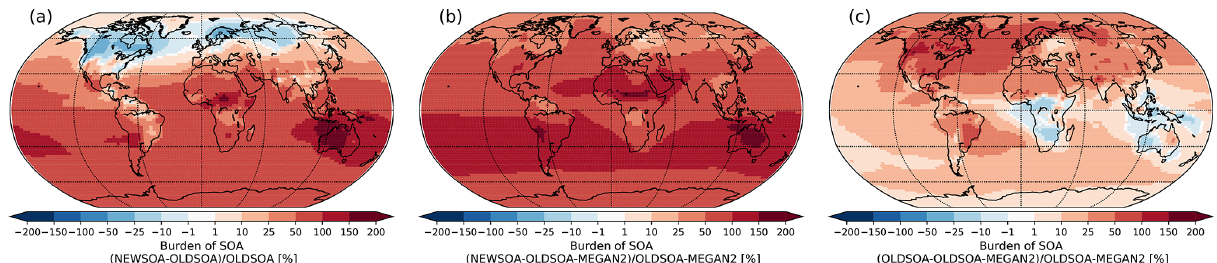
Figure 5. Fractional change in atmospheric burden of secondary organic aerosol between simulations NEWSOA and OLDSOA (a) , OLDSOA and OLDSOA-MEGAN2 (b) , and NEWSOA and OLDSOA-MEGAN2 (c) .